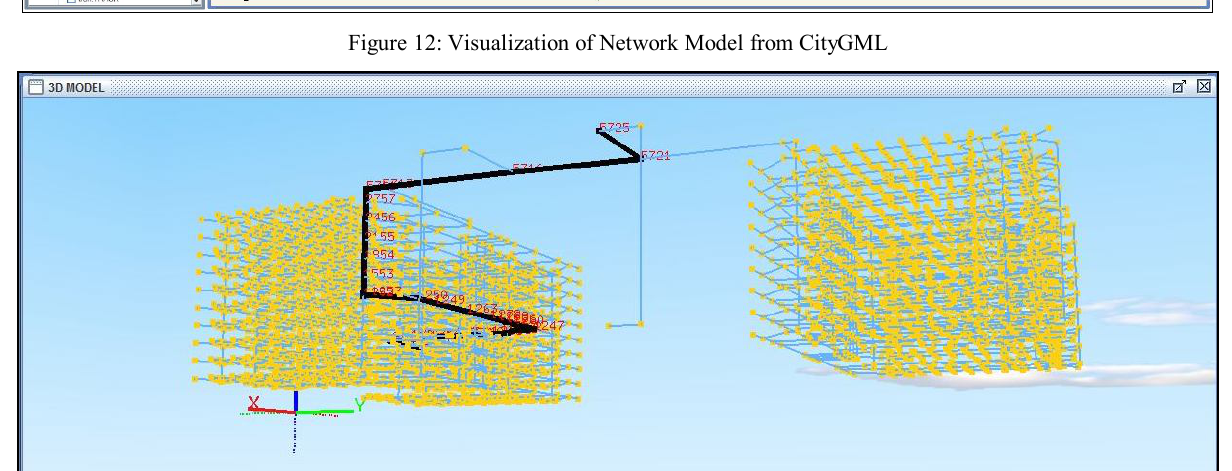
Figure 13: 3D Network Analyses on the Network Model in CityGML